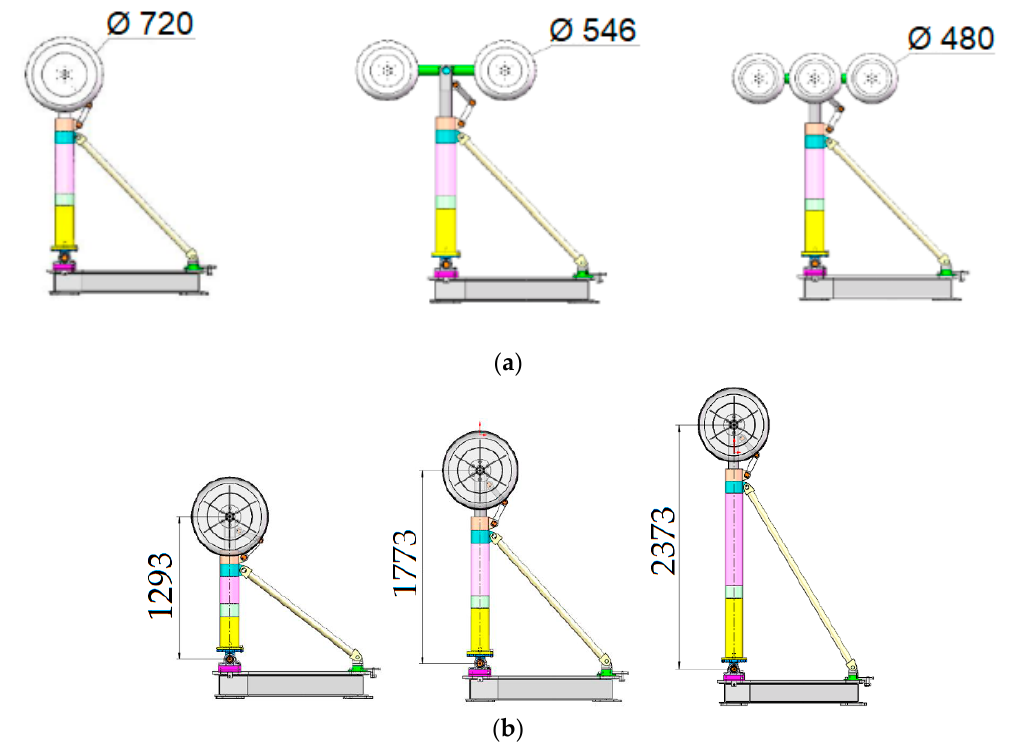
Figure 8. Schemes of full-scale landing gear models with different geometric parameters: ( a ) land- ing gears with different number and diameters of wheels; ( b ) landing gears with different main leg heights.